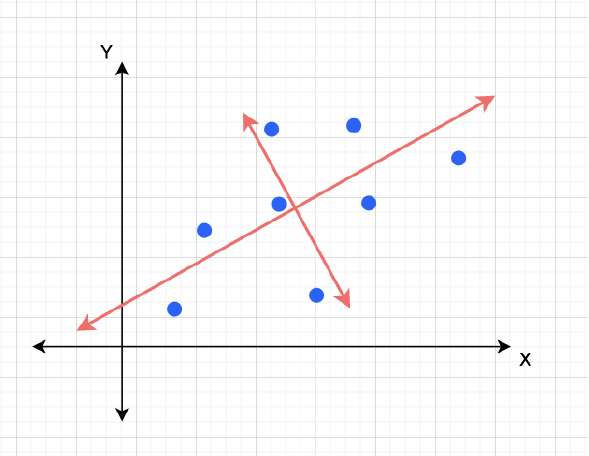
Figure 4. Projection of data points in two dimensions.